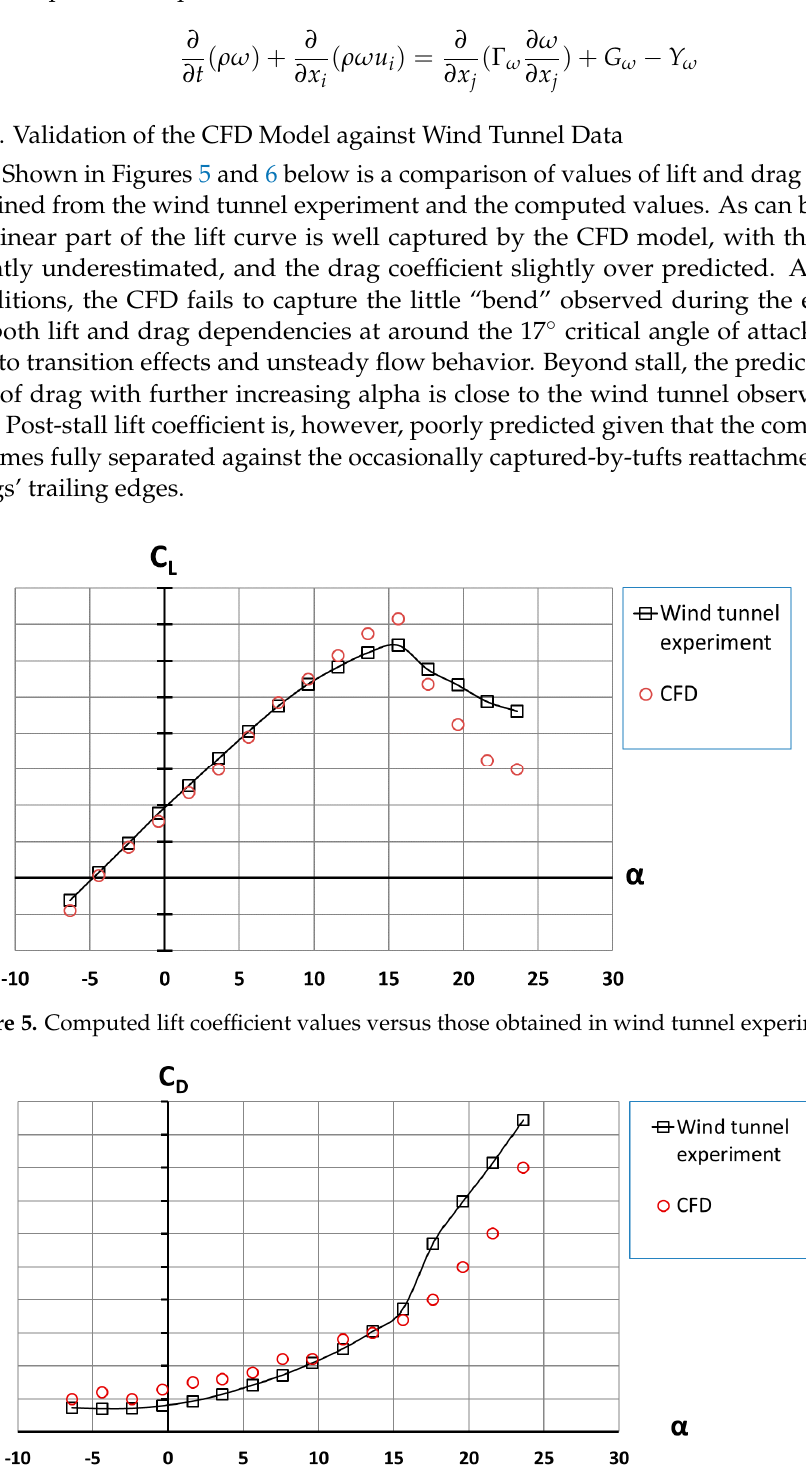
Figure 6. Computed drag coefficient C D versus wind tunnel data.